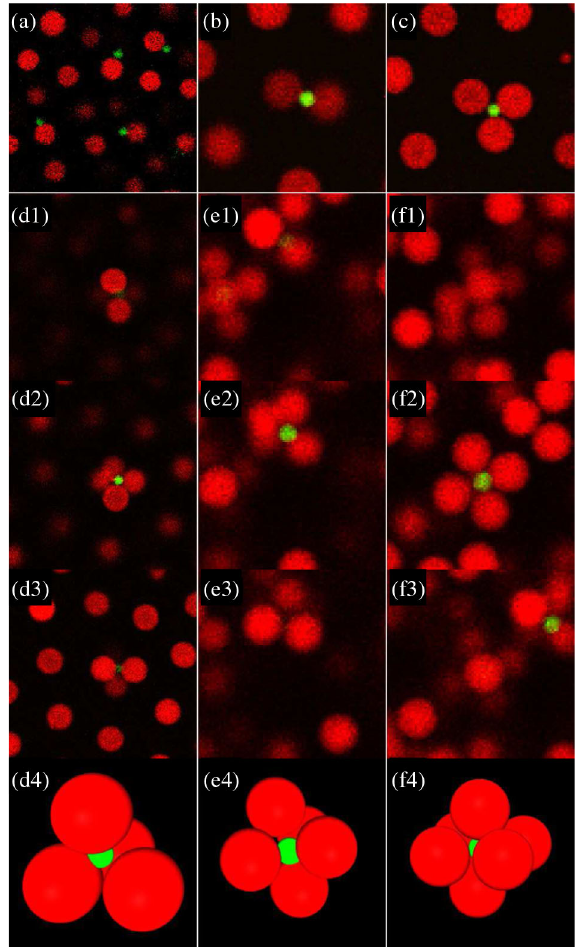
FIG. 1. Confocal microscopy images and computer-generated images of observed clusters consisting of a negatively charged core PMMA particle surrounded by one or more positively charged PMMA particles in CHB/ cis -decalin. In a mixture of positively charged ( σ B ¼ 4025 nm, red) and negatively charged particles ( σ A ¼ 1380 nm, green), σ B ∶ σ A ¼ 3 ∶ 1 , (a) dimers (b) linear clusters, (c) triangular clusters, and (d) tetrahedral clusters are formed. When slightly smaller satellite particles ( σ B ¼ 3025 nm, red) are used ( σ B ∶ σ A ¼ 2 . 2 ∶ 1 ), (e) triangular bipyramids and (f) octahedral clusters are formed. (d4) – (f4) Computer-generated 3D reconstructions from the particles ’ coordinates obtained from confocal images at different heights in the